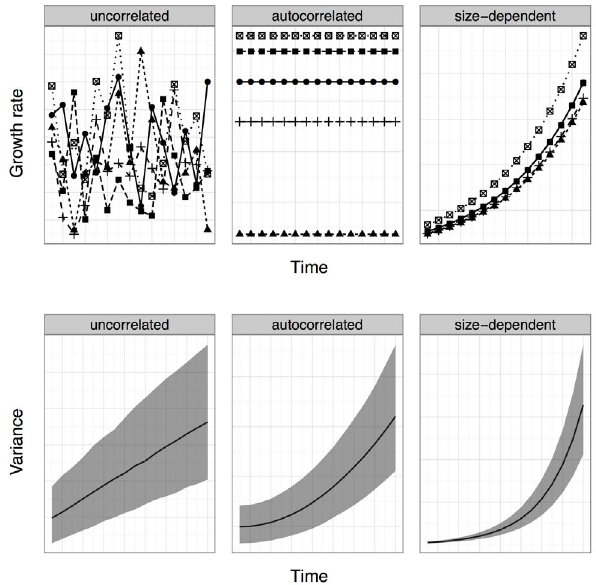
Figure 1. Simulated growth of individuals: growth parameters are the same across panels except for the assumptions: (left) uncorrelated variation among individuals, (center) autocorre- lated variation, (right) positively size-dependent growth. A - Patterns of growth rate Growth rates of five individuals are represented in each graph by five separate lines. B - Patterns of size variation Average cohort variance in 2000 cohorts of 50 indviduals: mean (solid line) and 2.5% and 97.5% quantiles (grey ribbons).